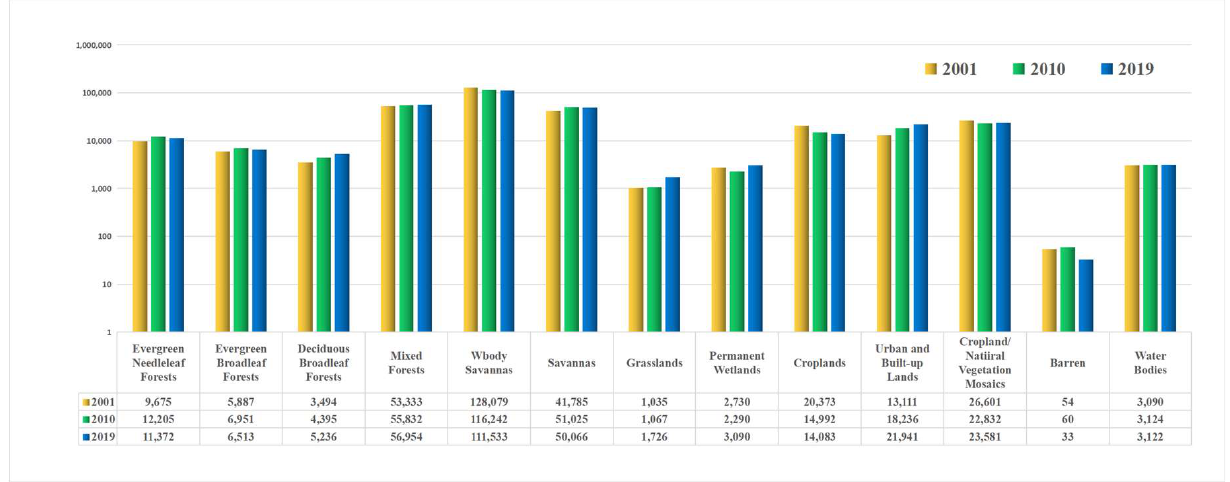
Figure 5. Areas of various types of land use in 2001, 2010, and 2019 (note: some land use types with a very small area are ignored).